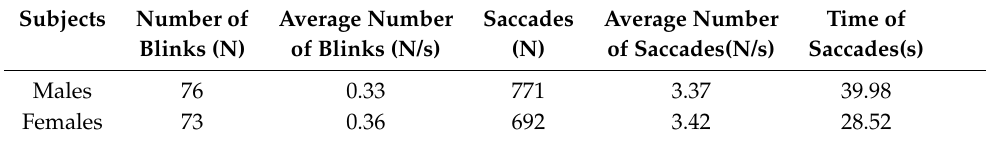
Table 4. Variation in pupil distance between subjects of different genders during complex task interaction. Subjects Number of